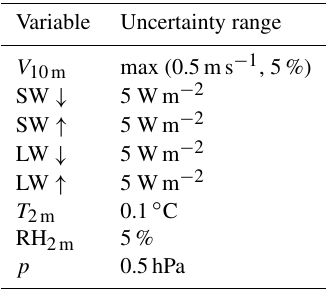
Table 1. Listing of used measurement variables and their associated measurement